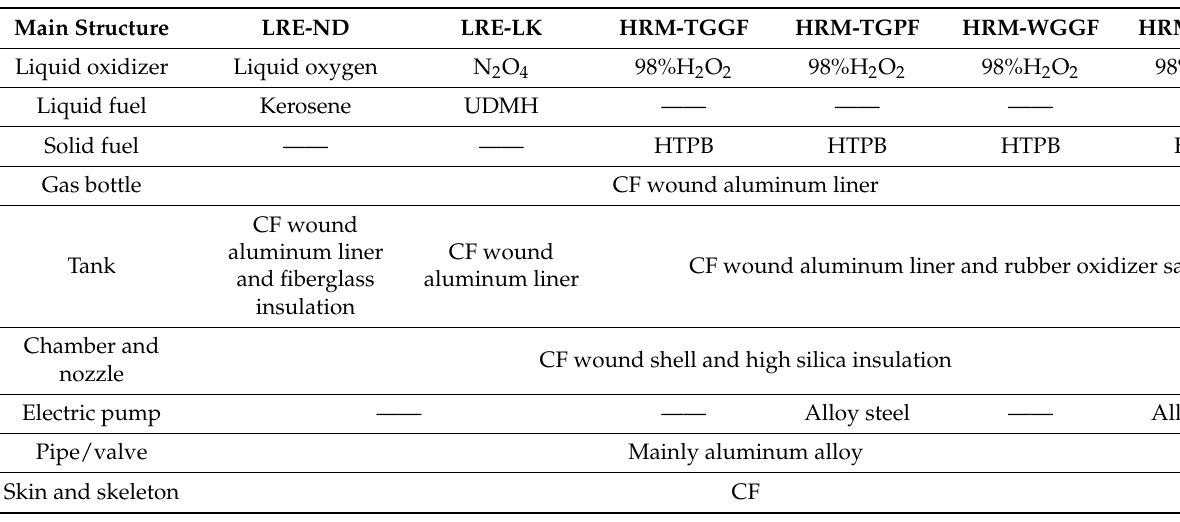
Table 1. Main structure of the manned lunar lander’s propulsion